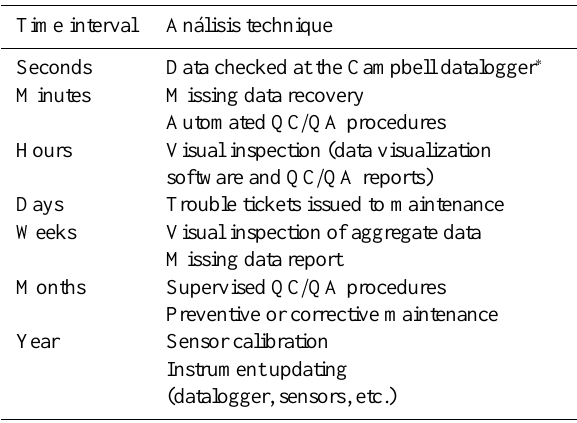
Table 1. Timescales of QC / QA procedures used by the Basque Country Mesonet (based on Shafer et al., 2000).